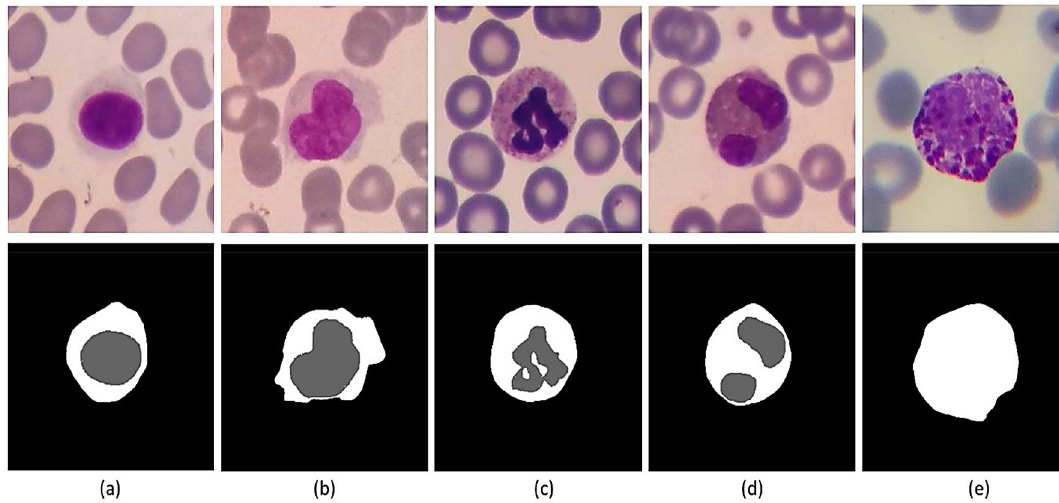
Figure 9. Some samples of ground truths provided in the Raabin-WBC dataset. First row contains the original cropped images of white blood cells. Second row contains the ground truths of some nuclei and cytoplasm. The columns ( a ), ( b ), ( c ), ( d ), and ( e ) show lymphocyte, monocyte, neutrophil, eosinophil, and basophil,